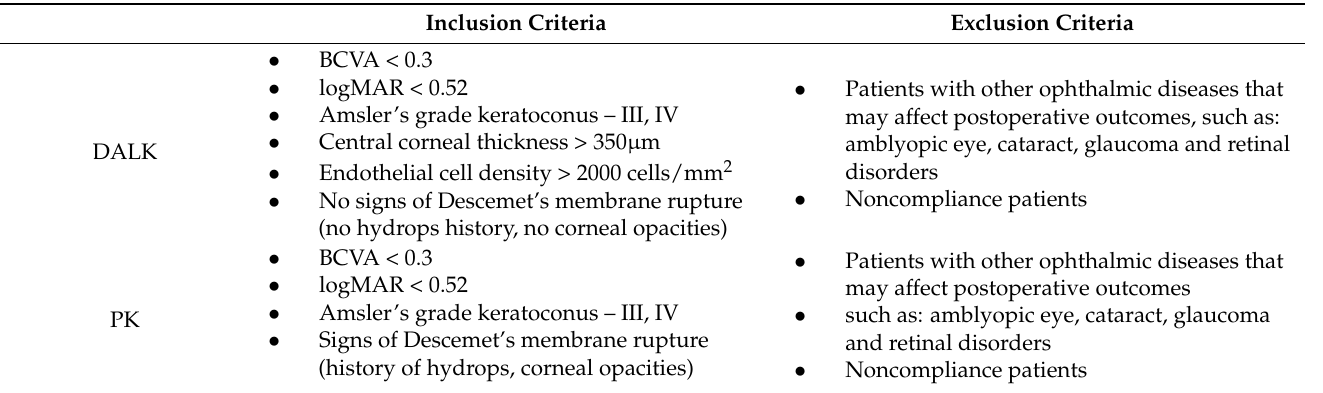
Table 1. Inclusion criteria for the deep anterior lamellar keratoplasty and penetrating keratoplasty groups. Inclusion Criteria Exclusion